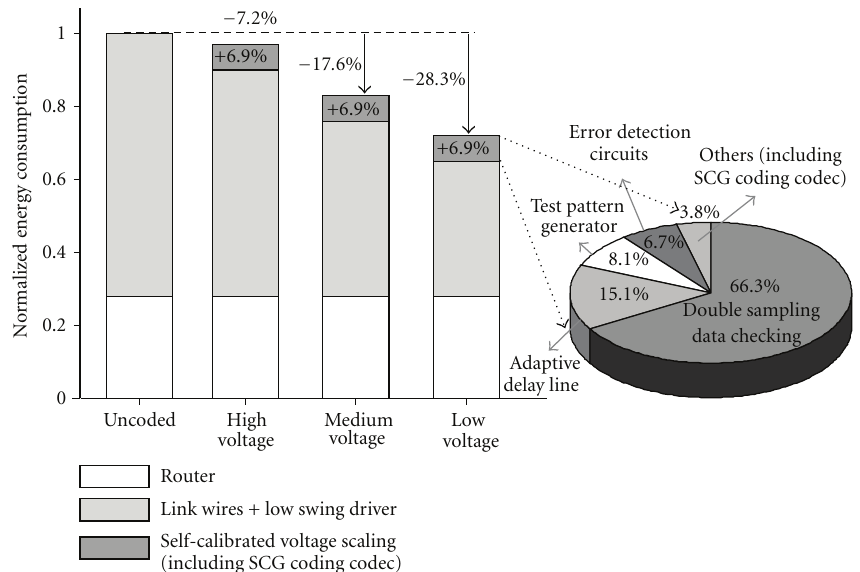
Figure 21: Energy analysis of the self-calibrated energy-e ffi cient and reliable interconnection architecture.